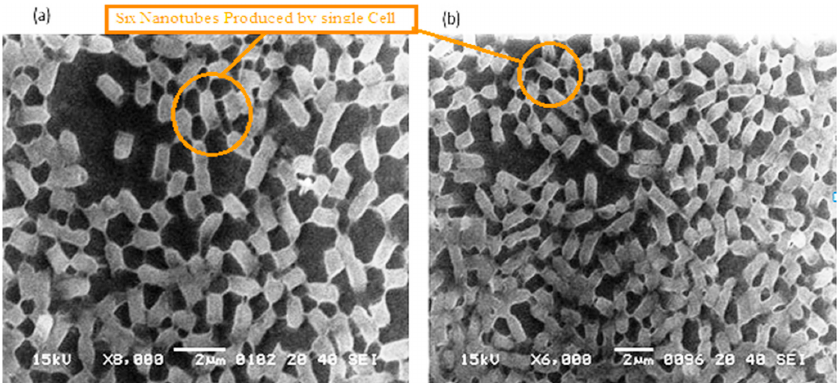
Figure 2. ( a , b ): These cells also occupied the lower base of biofilm consortia and adhered to the glass surface. This population was grown in between two slides under a weight of (15.45 g). Due to the stress of weight, cells were unable to maintain the typical P. aeruginosa shape (rod shape). However, these cells developed an interconnected network of nanotubes and covered the whole surface in a mesh-like structure.